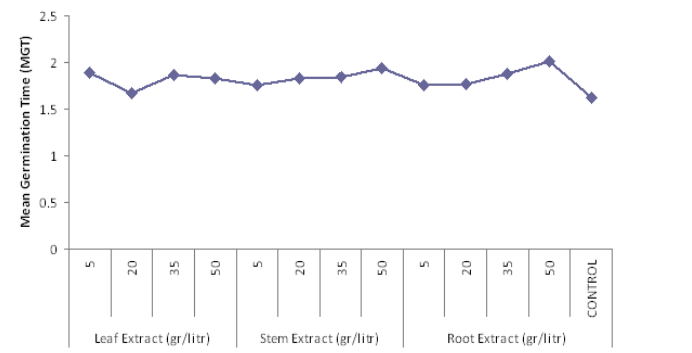
Fig. 2. The effect of sorghum extract on mung bean germination rate